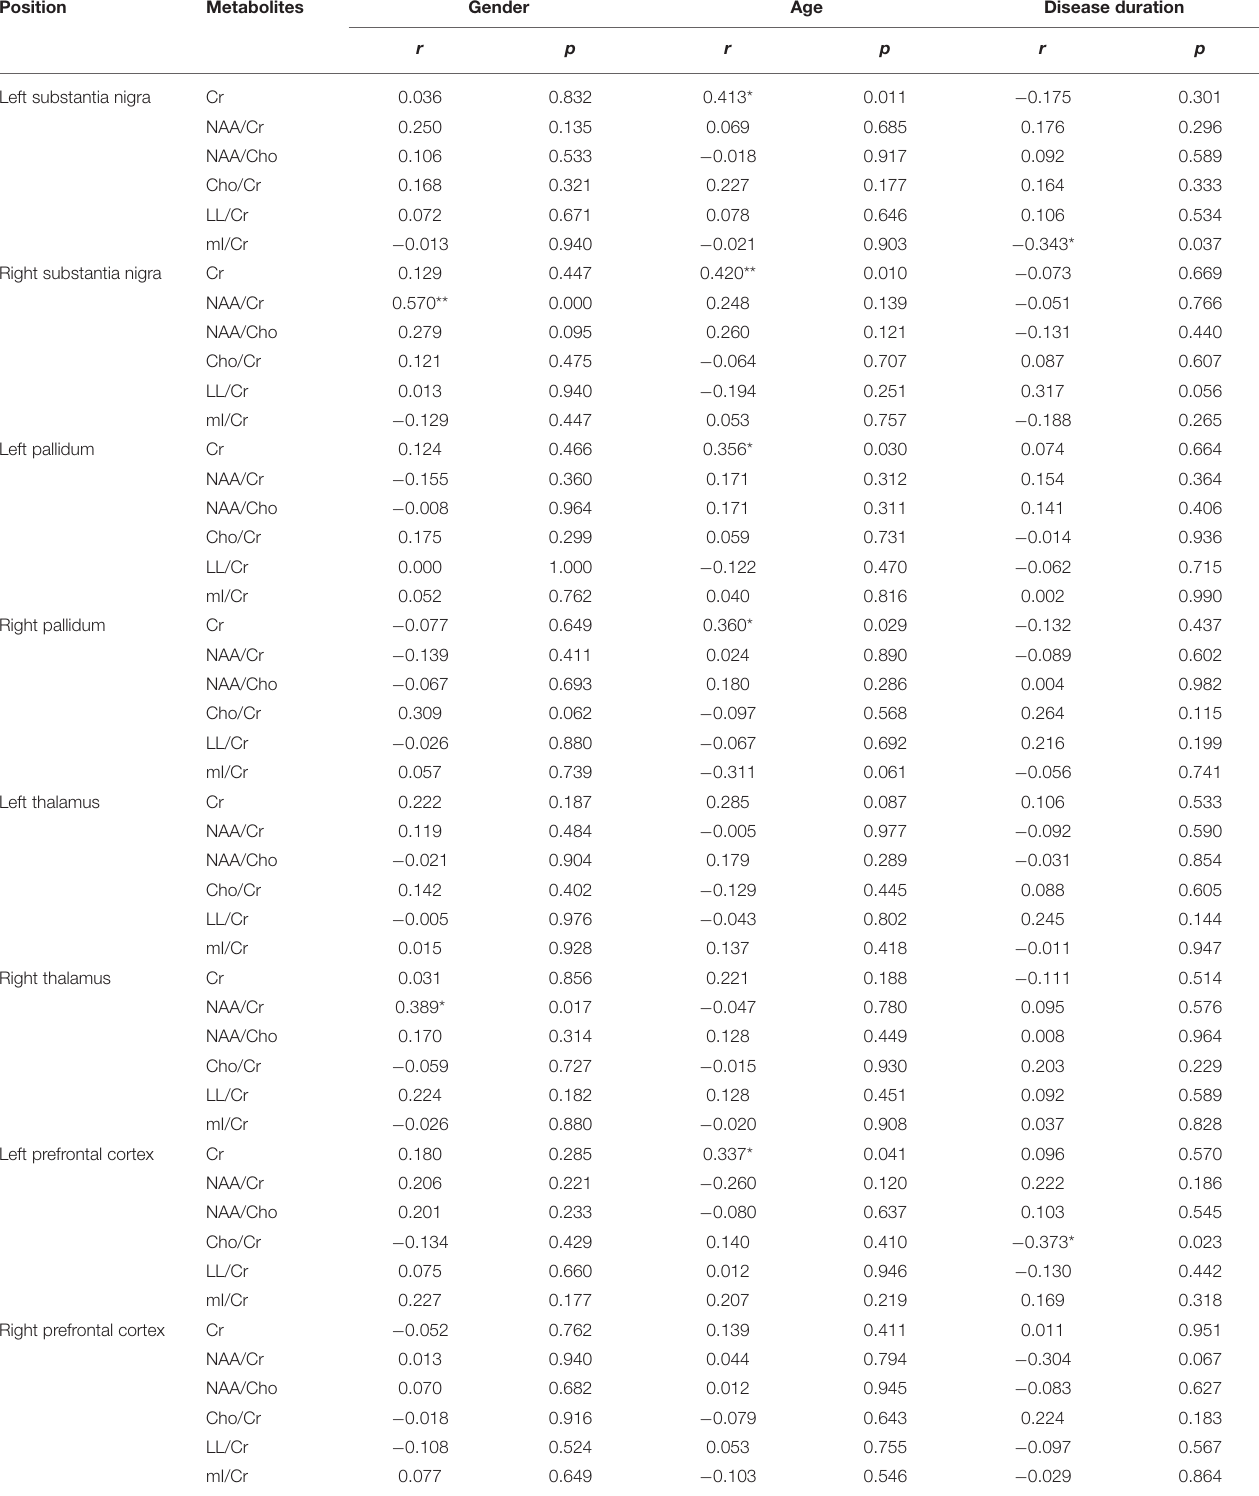
TABLE 5 | Relationship between cerebral metabolites and clinical factors including age, gender, disease duration, H&Y scale, UPDRS score, NMSS score, hypertension and diabetes in PD patients was shown by using spearman correlation analysis.